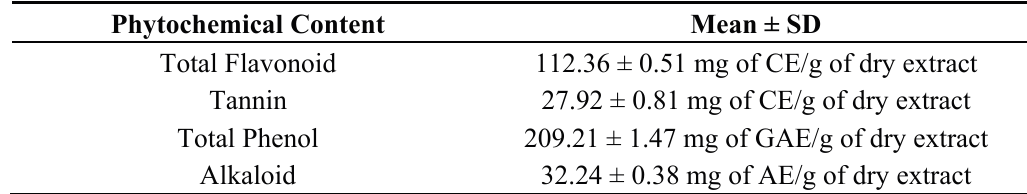
Table 1. Phytochemical contents of